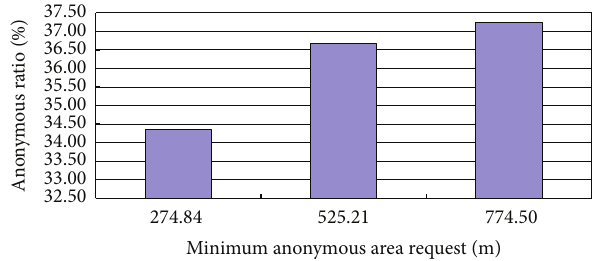
Figure 3: Ratio of the temporal-spatial anonymity with different anonymous space